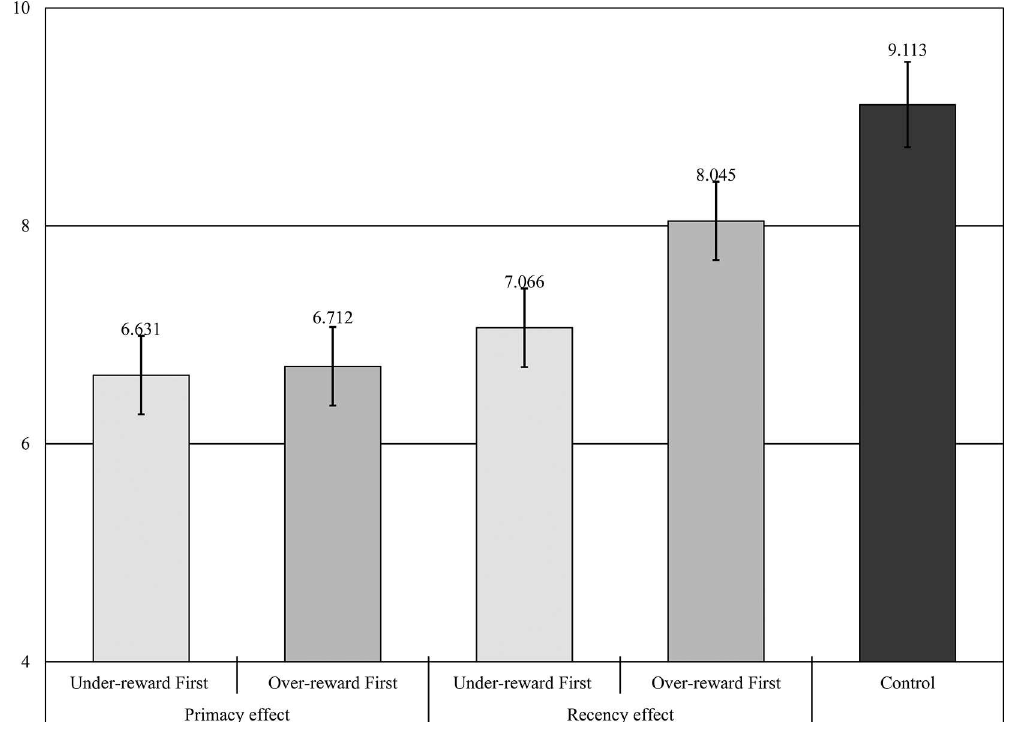
Fig 4. Estimated Justice Evaluations across the Conditions.